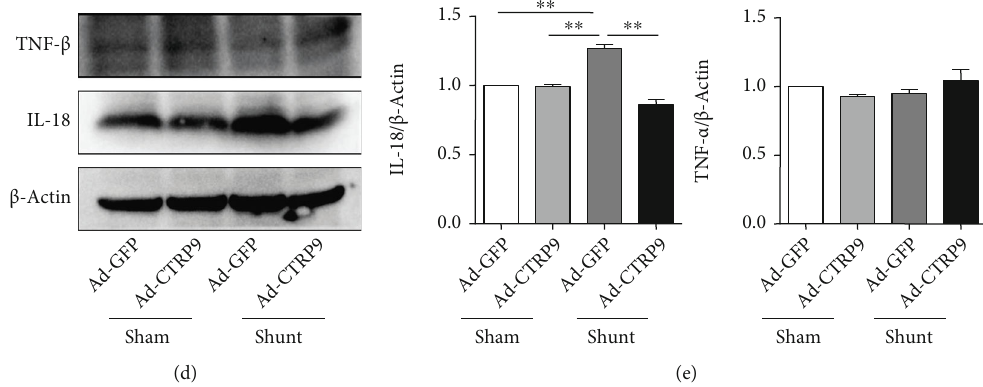
Figure 3: CTRP9 suppresses in fl ammation in vivo. (a) The interleukin 18 (IL-18), IL-10, monocyte chemoattractant protein-1 (MCP-1), IL- 6, F4/80, and tumor necrosis factor alpha mRNA expression levels were analyzed by RT-qPCR. (b, d) Injection of the rats with CTRP9 in the sham and shunt groups reduced the protein expression of MCP-1, IL-6, TNF- α , and IL-18, as assessed by immunoblot analysis of the total lung tissue. (c, e) Representative western blots of the total lung tissues indicating the induction of the in fl ammatory markers MCP-1, IL-6, TNF- α , and IL-18 following treatment of the rats with CTRP9 in the shunt group ( β -actin was used as a loading control) n = 6 for each group. In (b) and (d), the protein molecular weight of the MCP-1 (18 kDa), IL-6 (21 kDa), TNF- α (26 kDa), and IL-18 (22 kDa) was very similar, so they were all originating from the same gel. After exposure of the MCP-1 or TNF- α , we striped the primary antibody by the striping solution from the membrane and incubated the TNF- α antibody or IL-18 antibody. So, we use the same β -actin blot banding as the corresponding lading control from the same membrane. A total of 6 samples were selected from each group to perform RT-qPCR. The data are expressed as the mean ± SEM . ∗ P < 0 : 05 , ∗∗ P < 0 : 01 , and ∗∗∗ P < 0 : 001 vs. the Ad-GFP-sham group. IL: interleukin; MCP-1: monocyte chemoattractant protein-1; TNF- α : tumor necrosis factor alpha; RT-qPCR: reverse transcription-quantitative PCR; CTRP9: C1q/TNF-related protein 9; Ad-GFP: